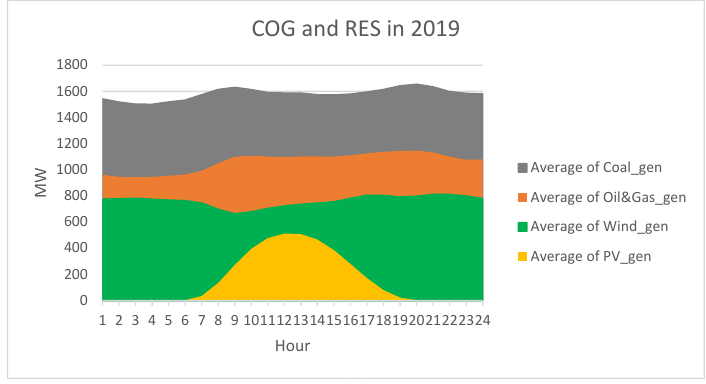
Figure 9. Average hourly operational output of the PV systems in Romania, in percentage.